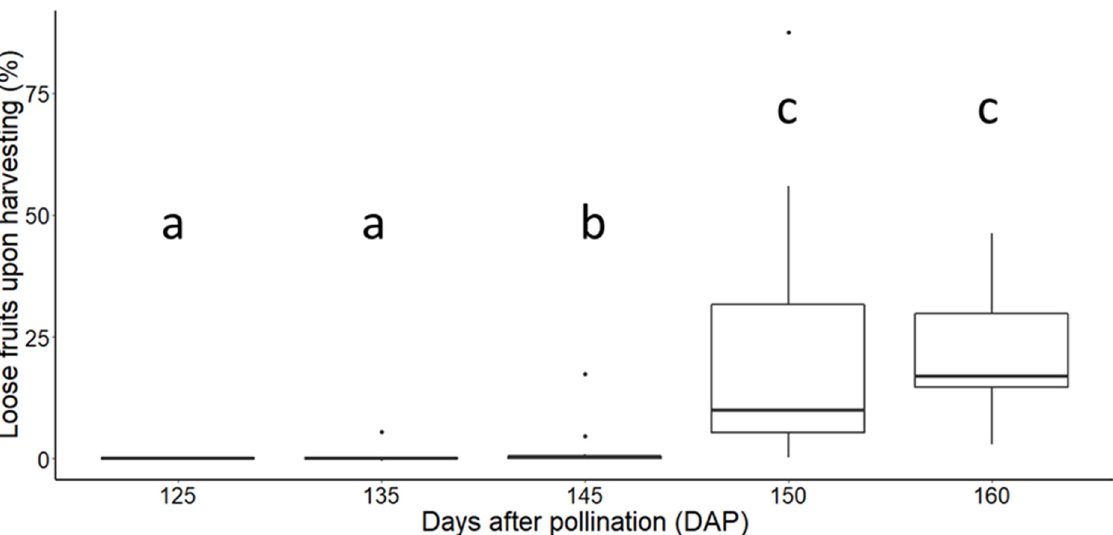
Figure 2. The boxplots represent median values, 25th–75th percentile of loose fruit percentage upon harvesting across FFB ripeness. Significant differences in loose fruit among the five DAP are denoted by a, b, and c based on Kruskal-Wallis test at the p = 0.05 threshold. Nineteen FFB harvested at 125 DAP have 0 loose fruit. Thirteen FFB harvested at 135 DAP have zero loose fruit with 1 outlier has 5.53% loose fruits. Ten FFB harvested at 145 DAP have less than 1.0% loose fruits, with 2 outliers having loose fruits 4.66% and 17.42%.